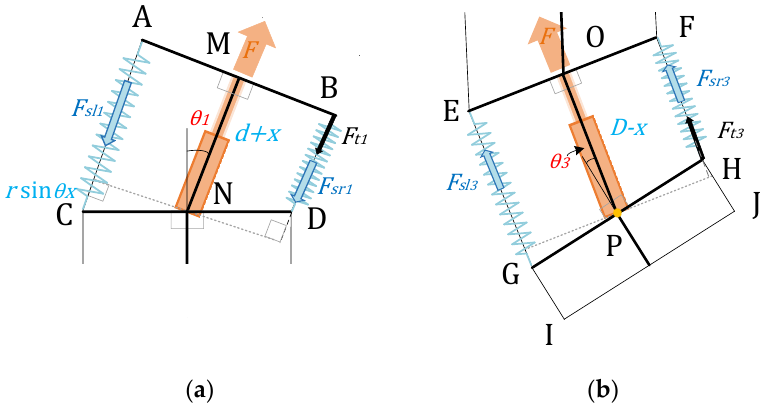
Figure 16. The force diagram at a certain point during Phase 1: ( a ) the force on Segment 1; ( b ) the force on Segment 4. In the diagram, θ 1 and θ 3 are the deflection angles of segments 1 and 3, and x cylinder is the cylinder elongation.